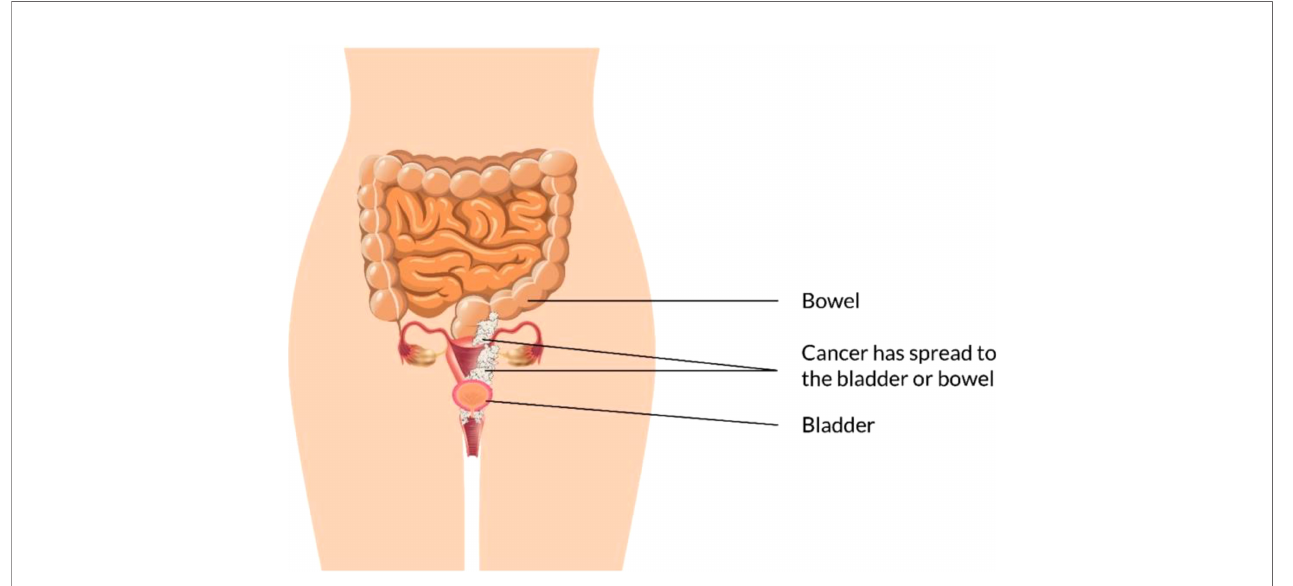
FIGURE 7 | Vaginal Cancer Stage